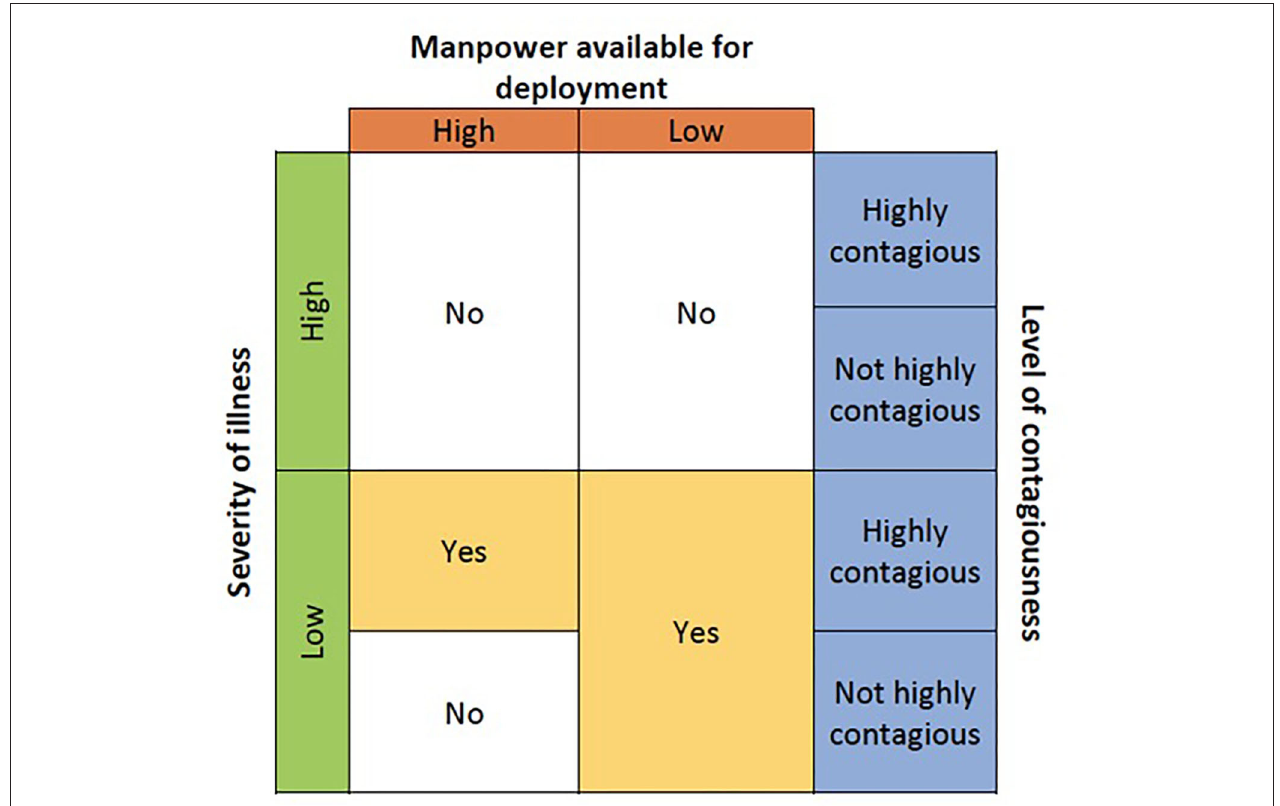
FIGURE 1 | Decision on whether a vital signs wearable is